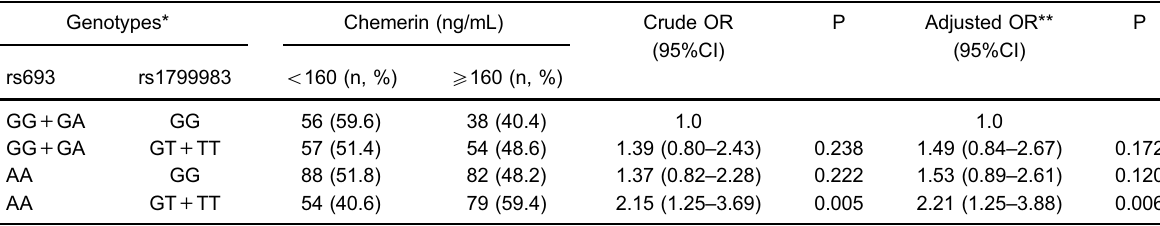
*Adjusted for sex, age, HOMA-IR (Homeostatic Model Assessment of Insulin Resistance), TG (triglycerides), and high-density lipoprotein cholesterol; a reference group: genotype homozygous for the ancestral allele; b risk group: genotype homozygous for the variant allele. Table 6. Bivariate risk association of genotypes of the polymorphisms APOB rs693 and NOS3 rs1799983 and levels of chemerin by quartiles in the study population.